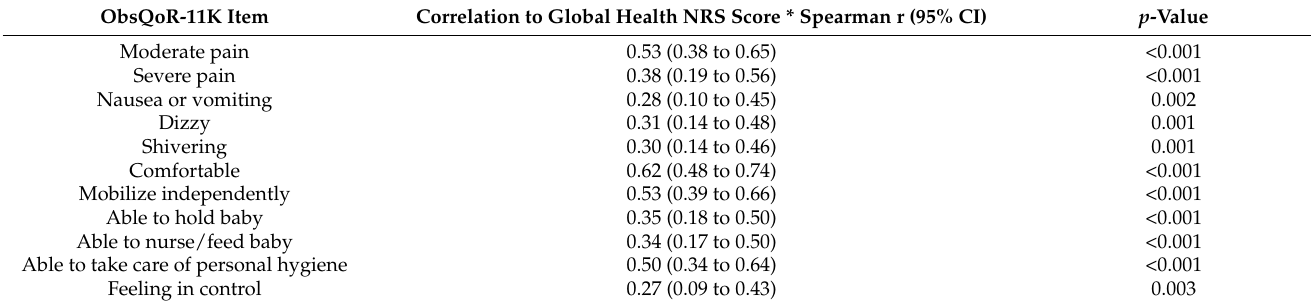
Table 2. Summary of correlations of ObsQoR-11K items to global health numerical rating scale (NRS). ObsQoR-11K